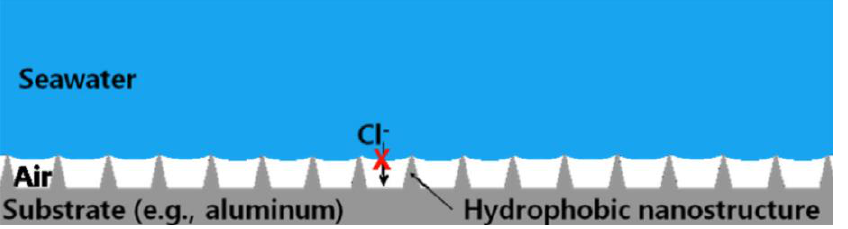
Figure 23. Effect of cavitation structure on corrosion resistance function (The red cross indicates that chloride ions cannot contact the metal substrate) (Reprinted with permission from Ref. [14]. 2015, Mohamed, A.M.A.).